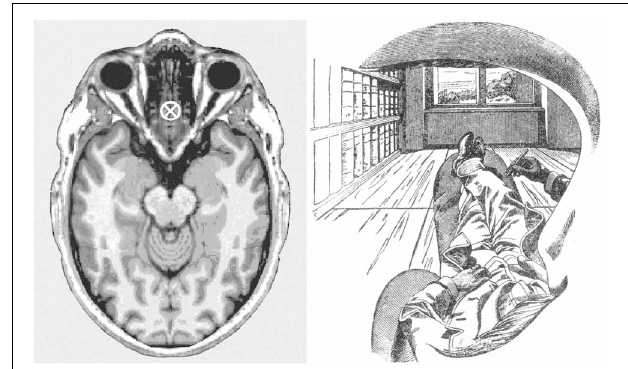
FIGURE 4 | Left panel: The present author’s visual egocenter, empirically determined by the method of Hering (Howard and Templeton, 1966), and transferred onto a horizontal structural magnetic resonance image of a human head at the level of the eyes, where it is marked by a cross (Image, © Nevit Dilmen found at Wikimedia commons, released under a Creative Commons Attribution-Share Alike 3.0 Unported license). Right panel: A monocular view from the visual egocenter, rendered by Ernst Mach through his left eye (Mach, 1897, Figure 1, p. 16). The dark fringe of Mach’s eyebrow appears beneath the shading in the upper part of the figure, the edge of his moustache at the bottom, and the silhouette of his nose at the right-hand edge of the drawing. These close-range details framing his view are available to our visual experience, particularly with one eye closed, though not as crisply defined as in this drawing. In a full cyclopean view with both eyes open the scene is framed by an ovoid within which these proximal details typically disappear from view. Apparently Mach was a smoker, as indicated by the cigarette extending forward beneath his nose. Digitally retouched version of Mach’s drawing reproduced courtesy of Wikimedia (http://commons.wikimedia.org/wiki/File:Ernst_Mach_Innenperspektive.png). Note the apparent impossibility of having an unobstructed view of a scene from the empirically determined point marked on the image on the left, a point which is surrounded on all sides by biological tissues (see further the